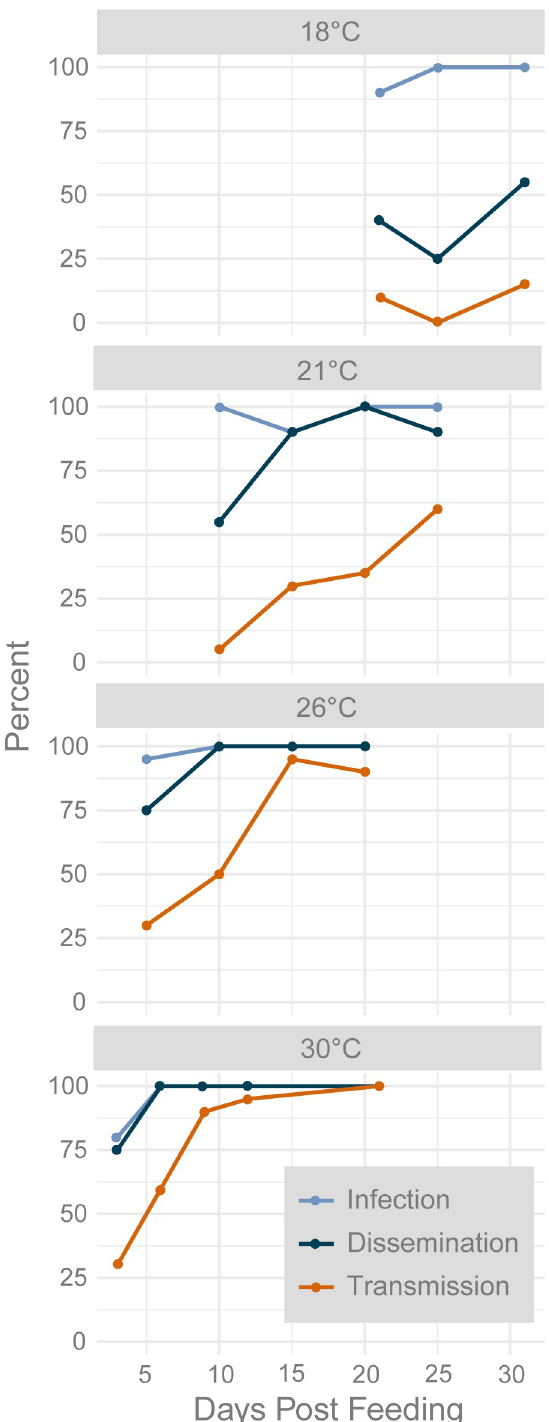
Fig 2. Percent of mosquitoes with infected, disseminated, and transmitted ZIKV vRNA of 20 tested at each temperature and time point combination tested. Samples were processed in duplicate by RT-qPCR. Ct values < 38 in at least one of the duplicates indicated positive